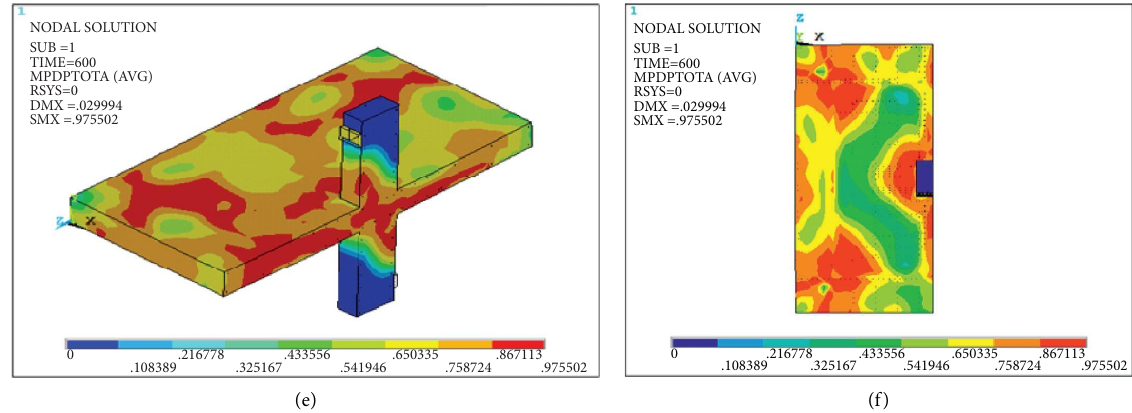
Figure 35: Concrete damage of specimens with varying post-earthquake fre exposure durations. (a) Specimen 200-45-1-ALL Bs-1800. (b) Bottom surface. (c) Specimen 200-45-1-ALL Bs-1200. (d) Bottom surface. (e) Specimen 200-45-1-ALL Bs-600. (f) Bottom surface.